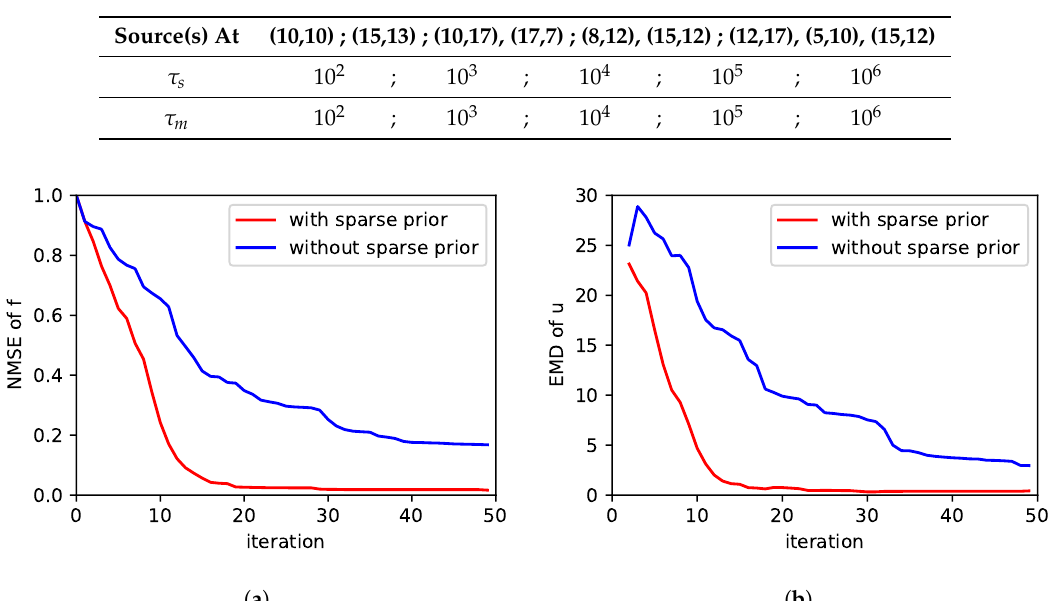
Table 2. Parameters used for simulation runs shown in Figure 3.